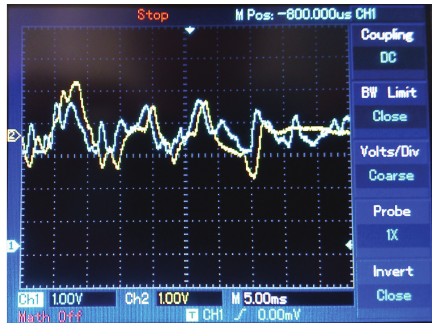
Figure 16: Random wave message. Blue: sent message. Yellow: retrieved